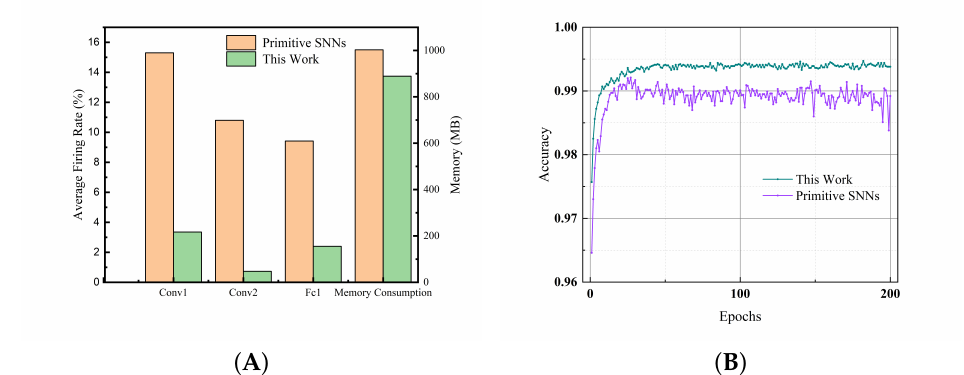
Figure 8. ( A ) The average firing rate of the spiking layer and memory usage per epoch . ( B ) The training curve of our model and the primitive SNNs, the final performance of our model is not only better than the original SNNs, but also converges